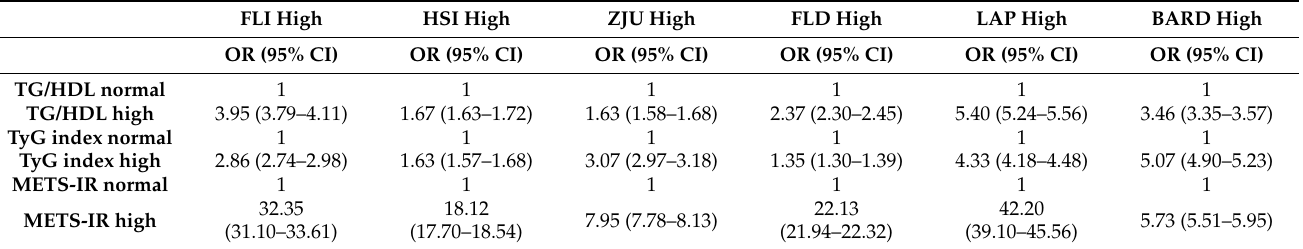
Table 4. Binomial logistic regression.